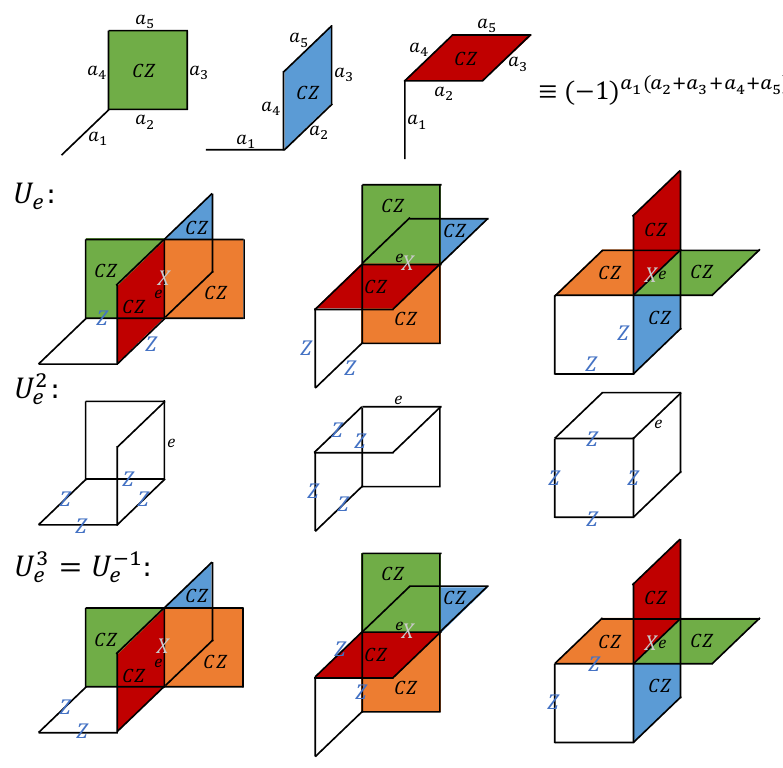
Figure 5: The operator U